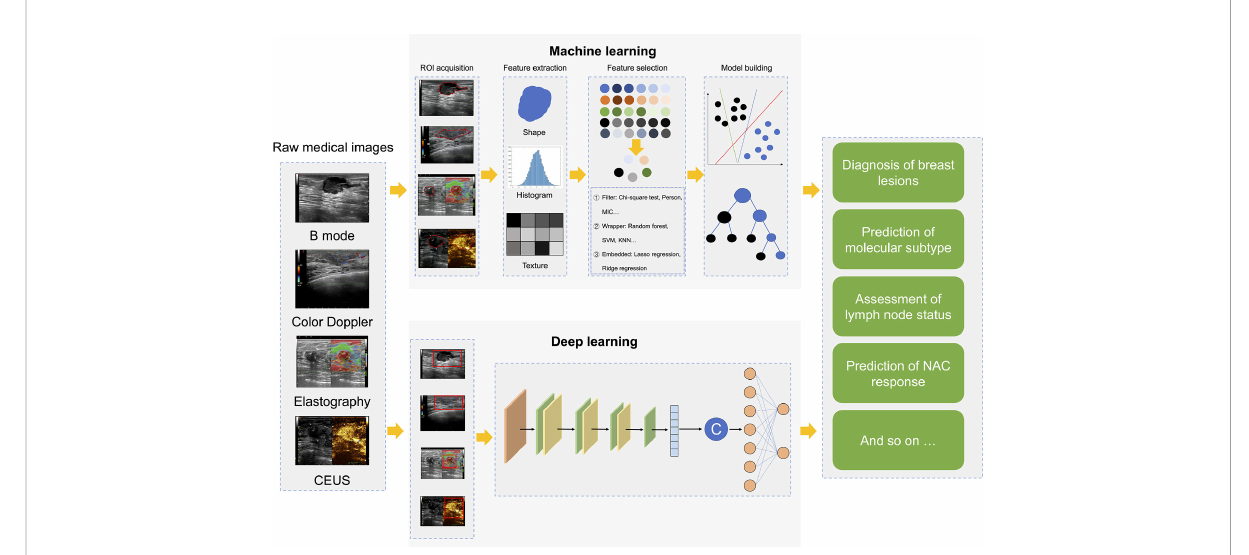
FIGURE 1 Radiomics work fl ows based on hand-crafted features or deep learning. CEUS, contrast-enhanced ultrasound; ROI, region of interest; MIC, mutual information and maximal information coef fi cient; SVM, support vector machine; KNN, k nearest neighbor; NAC, neoadjuvant